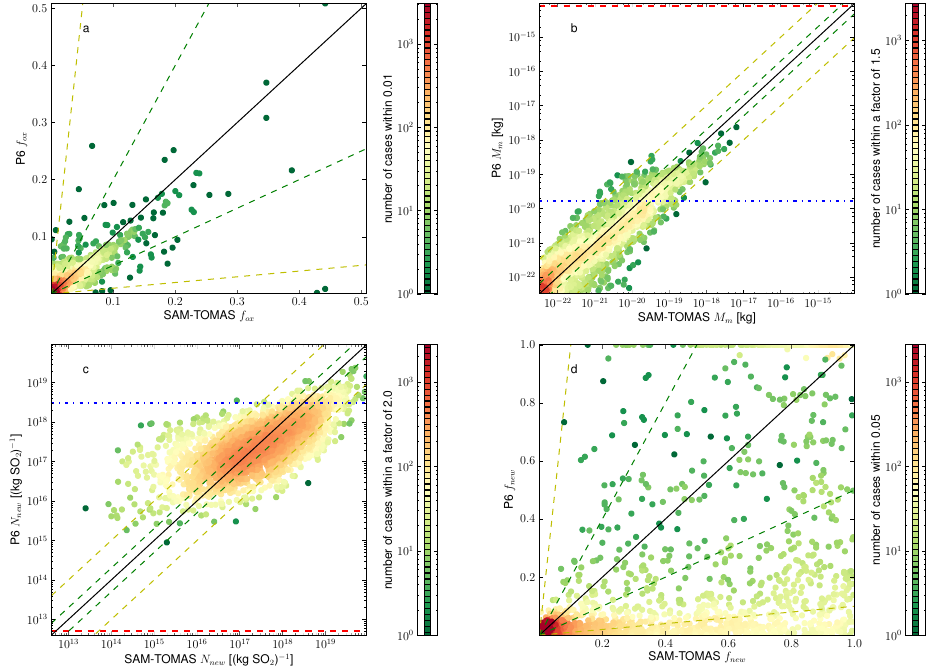
Fig. 1. P6 vs SAM-TOMAS values of f ox , M m , N new , and f new . Colour of points indicates density of cases. The red dashed lines indicate the values of M m and N new from Dentener et al. (2006), and the blue dash-dotted lines indicate the values of M m and N new from Adams and Seinfeld (2003). The green and yellow dashed lines indicate where the predicted values are within a factor of 2 and 10, respectively, of the calculated